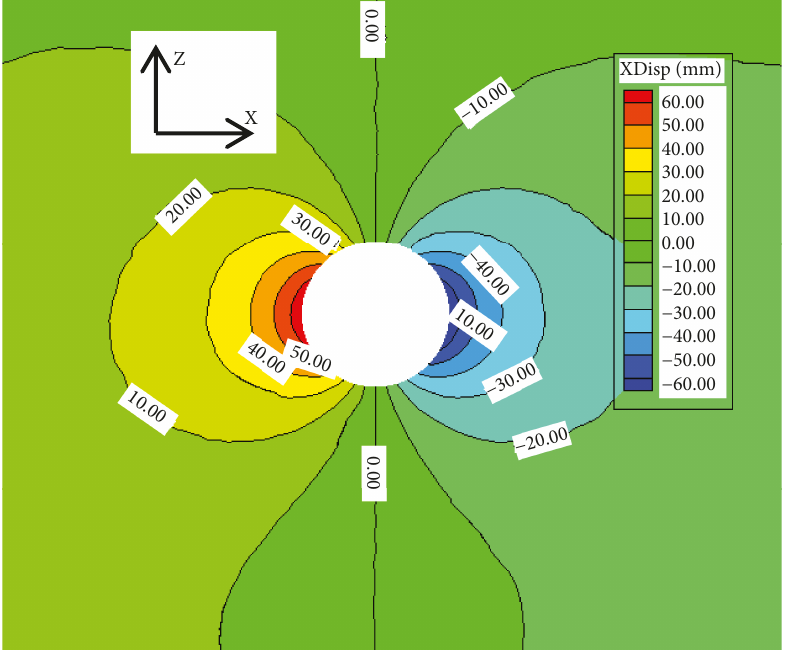
Figure 14: Displacement of section A-A along X.